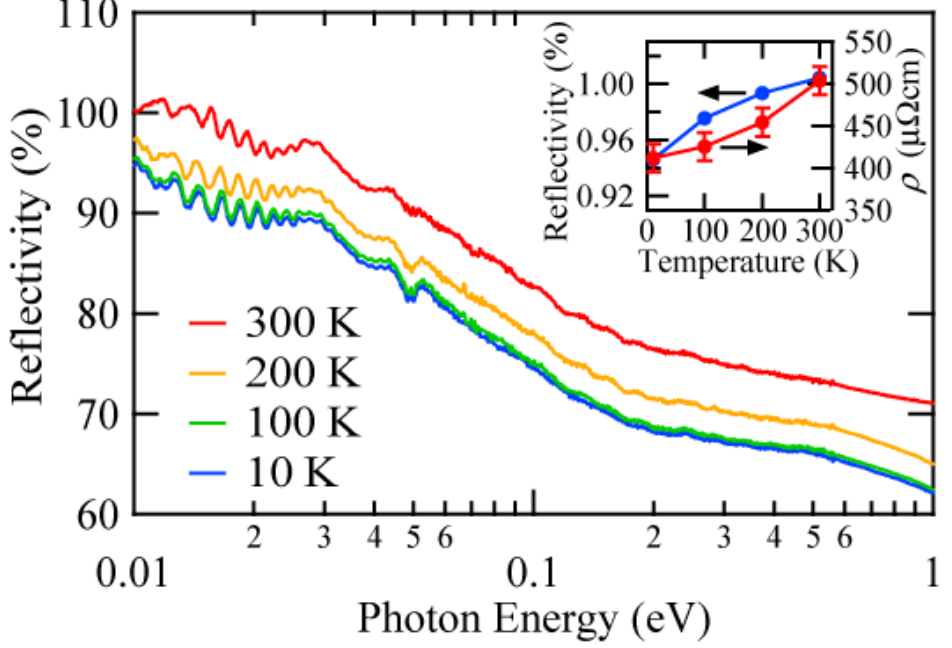
Figure 5. Experimental ( a ) and simulated ( b ) photoemission spectra of Fe 2 VAl and Ru 2 VAl with h ν = 6916 eV.